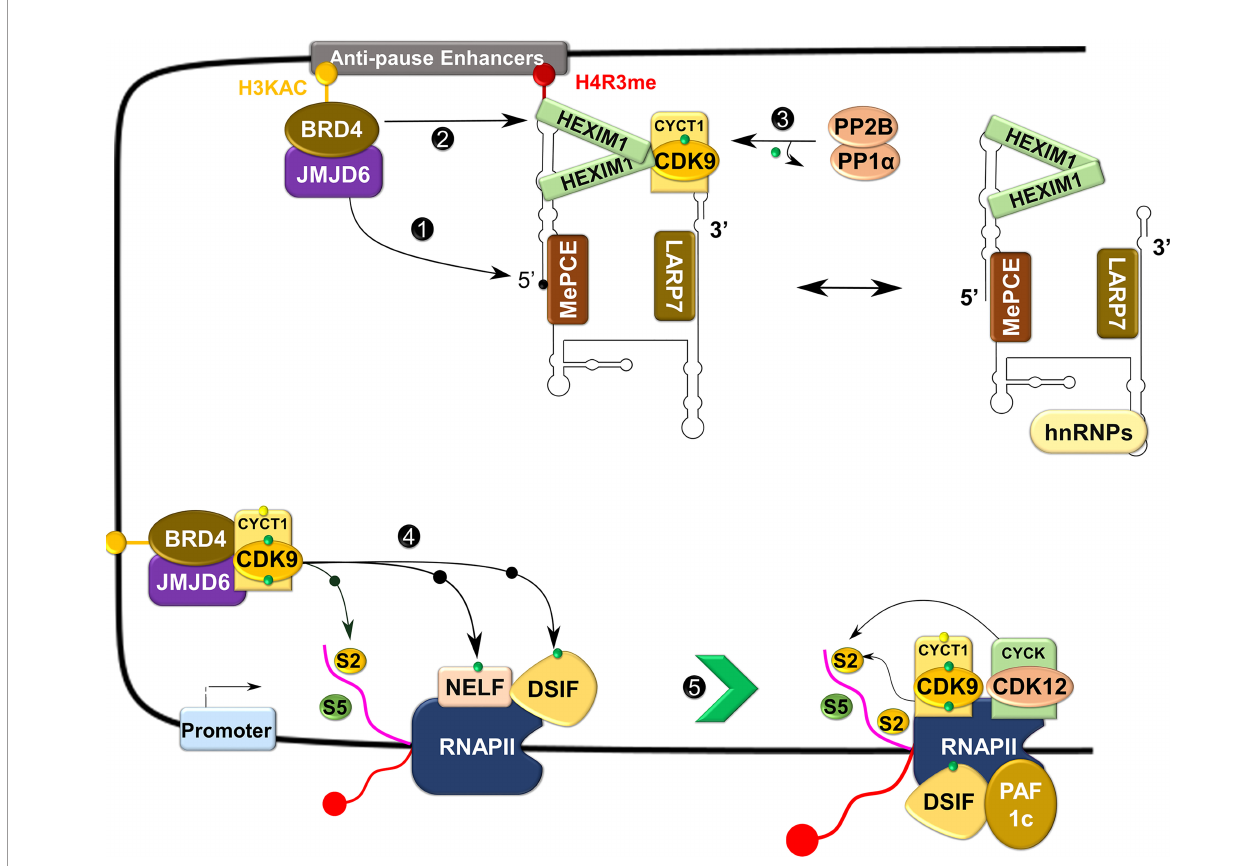
FIGURE 5 | Control of transcriptional elongation by P-TEFb. During active transcription, BRD4 recruits JMJD6 to 7SK snRNP anchored to anti-pause enhancers on chromatin. JMJD6 demethylates both H4R3me and the 5 ’ hairpin of 7SK RNA, breaking chromatin binding of the former and exposing the latter for degradation (Labelled as 1). Concurrently, acetylated histone (H3KAC)-bound BRD4 interacts with and extracts P-TEFb from 7SK snRNP (2). Protein phosphatases (PP2B and PP1 a ) also assist in the release of P-TEFb from 7SK snRNP by dephosphorylating CDK9 pThr186 (3). After release, CDK9 is re-phosphorylated on Thr186 by CDK7 and delivered by BRD4-JMJD6 to RNAP II that has been paused in the proximal promoter region. At this site, P-TEFb phosphorylates DSIF, NELF, and RNAP II CTD (4), allowing productive elongation